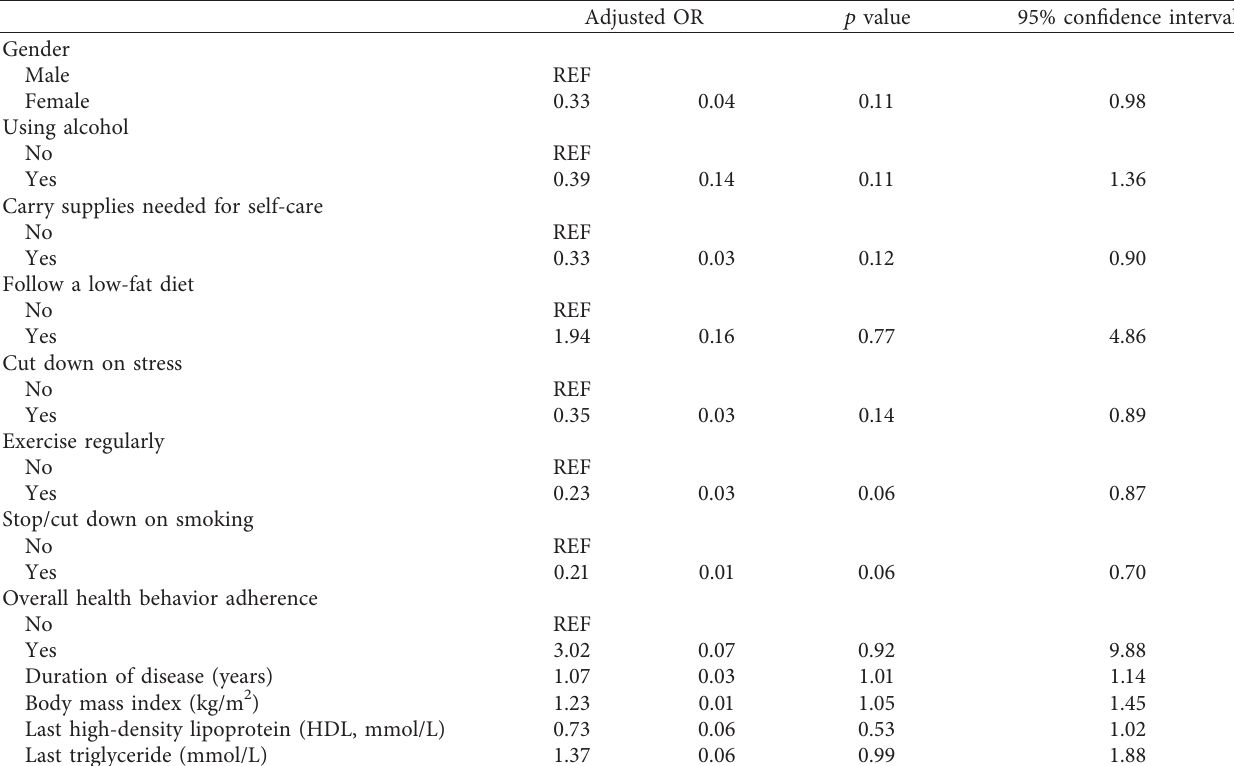
Table 4: Multivariate logistic regression to identify associated factors with uncontrolled